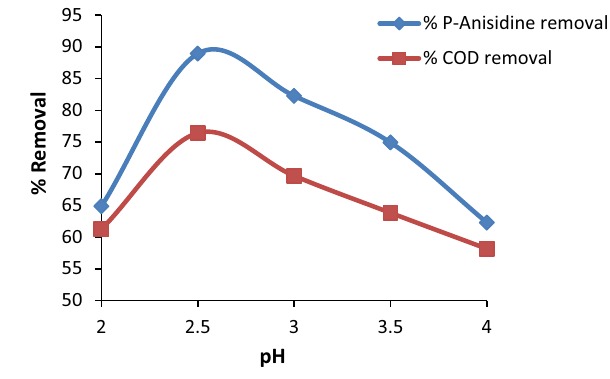
Fig. 2 Effect of pH on p -anisidine degradation by Fenton’s reagent